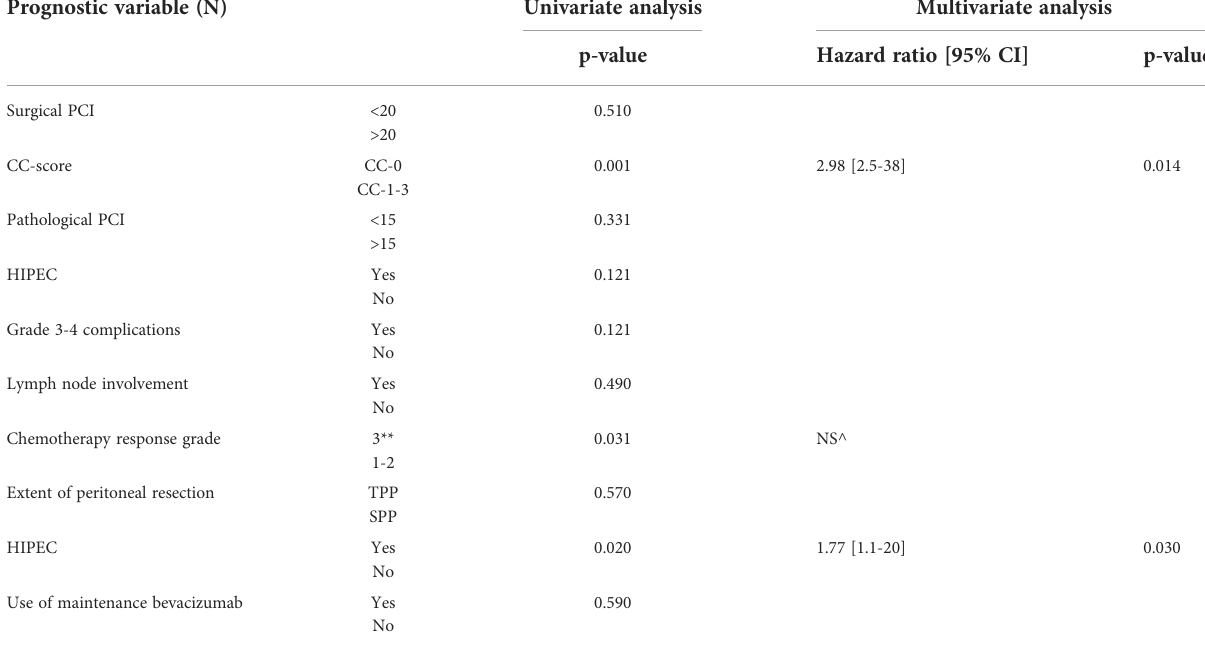
TABLE 4 Factors affecting recurrence within 12 months of surgery (logistic regression analysis)*.